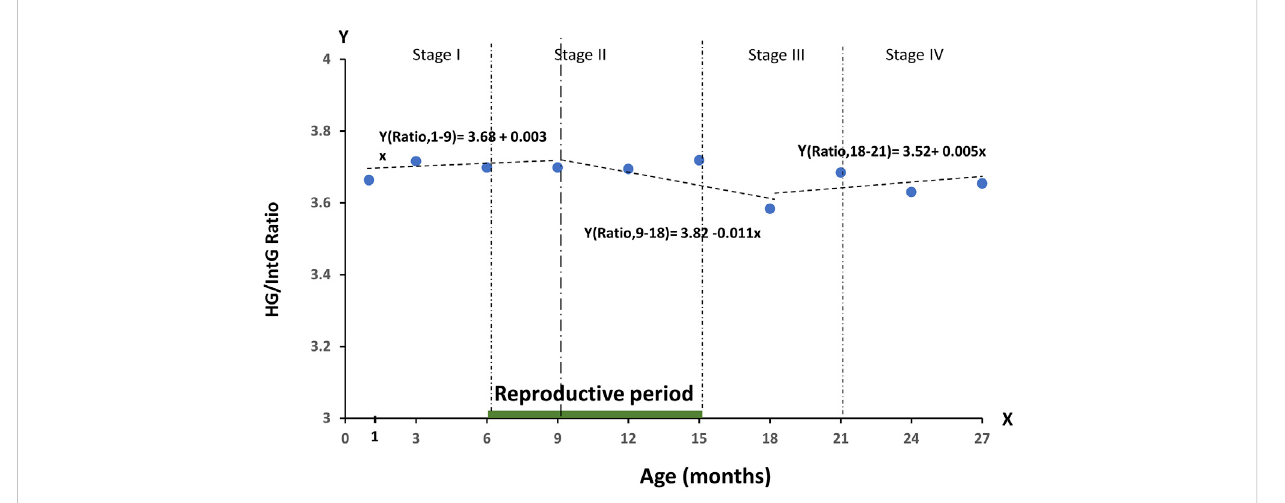
FIGURE 2 Dynamics of the RNA production ratio — HG/IntG in relative numbers during the observation period of age, divided into four stages of ontogenesis — Stage I (1 – 6 months), Stage II (6 – 15 months), Stage III (15 – 21 months), Stage IV (21 – 27 months)